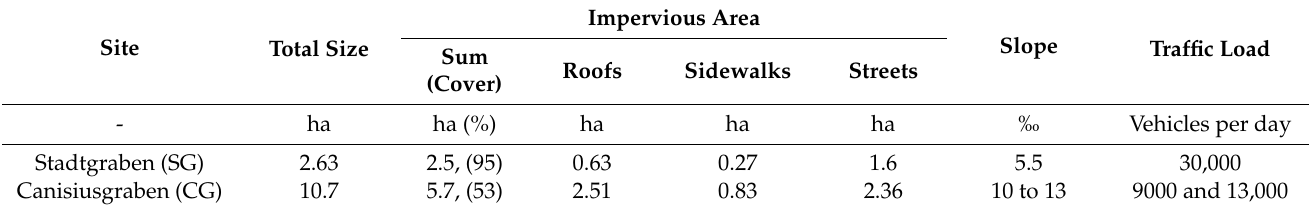
Table 1. Catchment characteristics of monitoring sites.